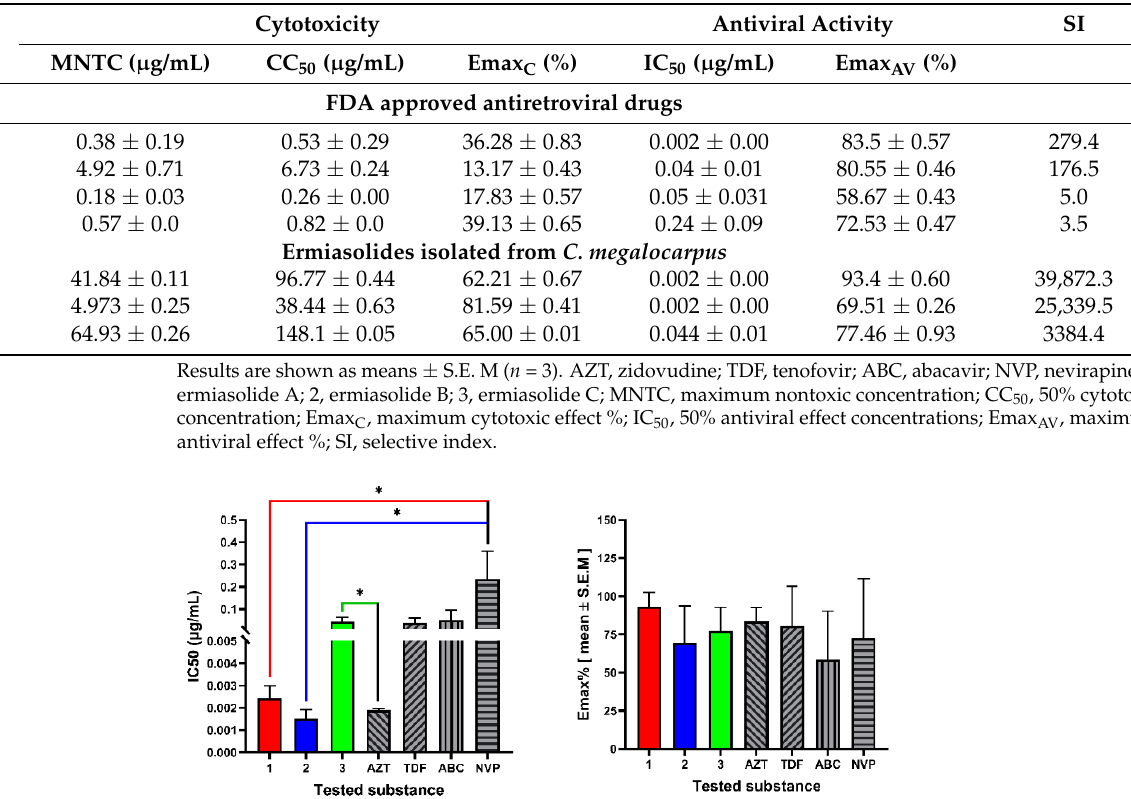
Figure 4. Anti-HIV activity of ermiasolides from C. megalocarpus. The results are expressed as the mean of three independent experiments ± S.E.M. AZT, zidovudine; TDF, tenofovir; ABC, abacavir; NVP, nevirapine; 1, ermiasolide A; 2, ermiasolide B; 3, ermiasolide C; MNTC, maximum nontoxic concentration; CC 50 , 50% cytotoxic concentration; EmaxC, maximum cytotoxic effect %; IC 50 , 50% antiviral effect concentrations; EmaxAV, maximum antiviral effect %; SI, selective index. C; control, ns, not significant, * Denotes p value < 0.05.